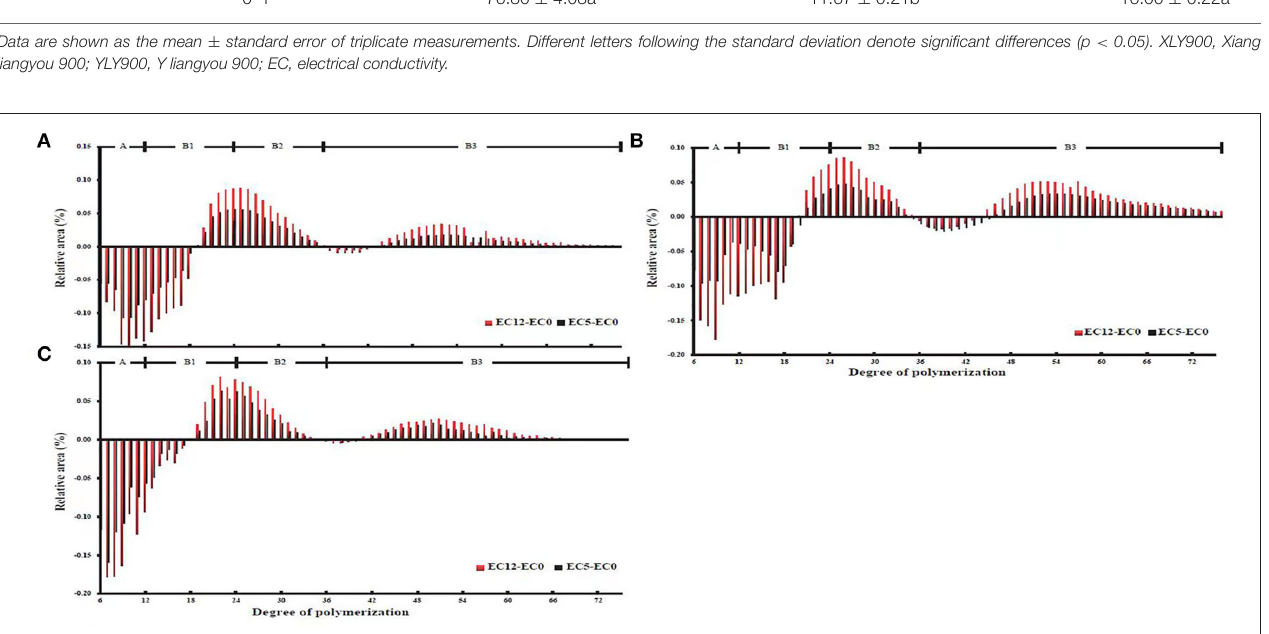
the electrical conductivity is 12, 5, and 0–1 dS/m,